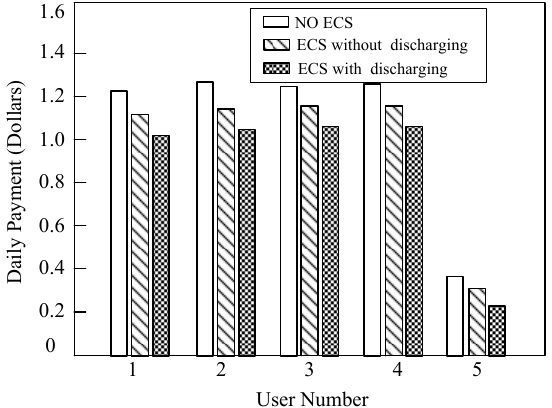
Figure 4. Daily electricity cost of each user having household appliances and/or a plug-in electric vehicle.